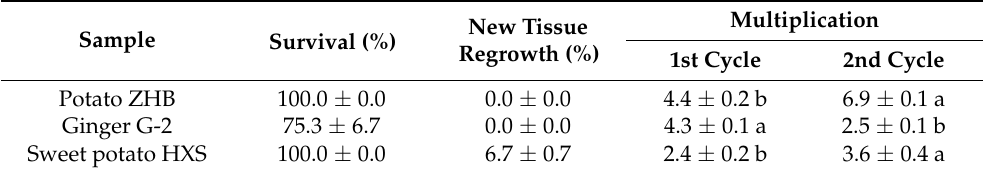
Table 4. Plant survival, new tissue regrowth, and subculture of packaged micro-cuttings conserved at 10 ◦ C in the dark with 1/4 MS 100